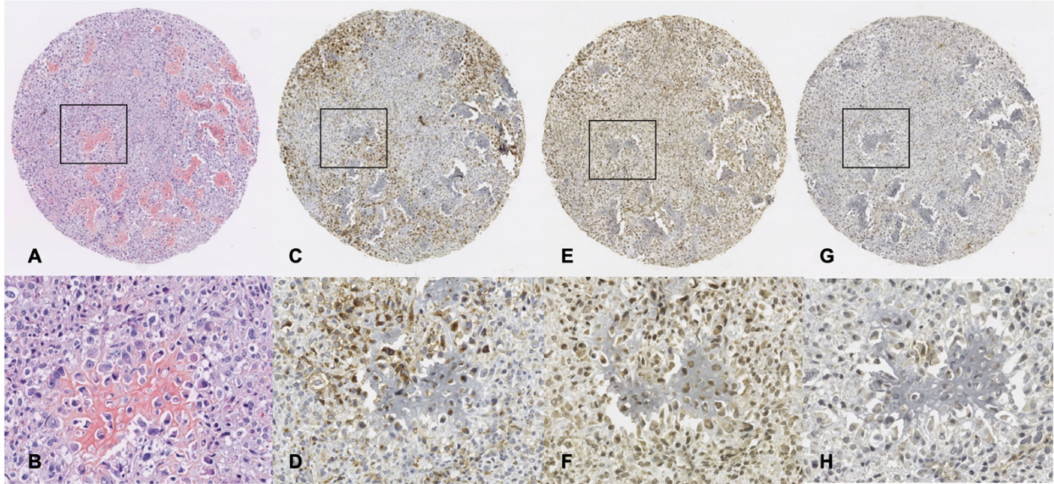
Figure 3. Representative patterns of GLUT-1, SphK1 and S1P 1 expression in osteosarcoma. ( A ), His- tological representation of one spot of an osteoblastic osteosarcoma included in TMAs (H&E mag- nification × 5), ( B ), Representation at a magnification × 25 of the zone framed in A; ( C , D ), GLUT-1 staining in the same spot (magnification × 5 and 25, respectively); ( E , F ), SphK1 staining in the same spot (magnification × 5 and 25, respectively); ( G , H ), S1P 1 staining in the same spot (magnification × 5 and 25,